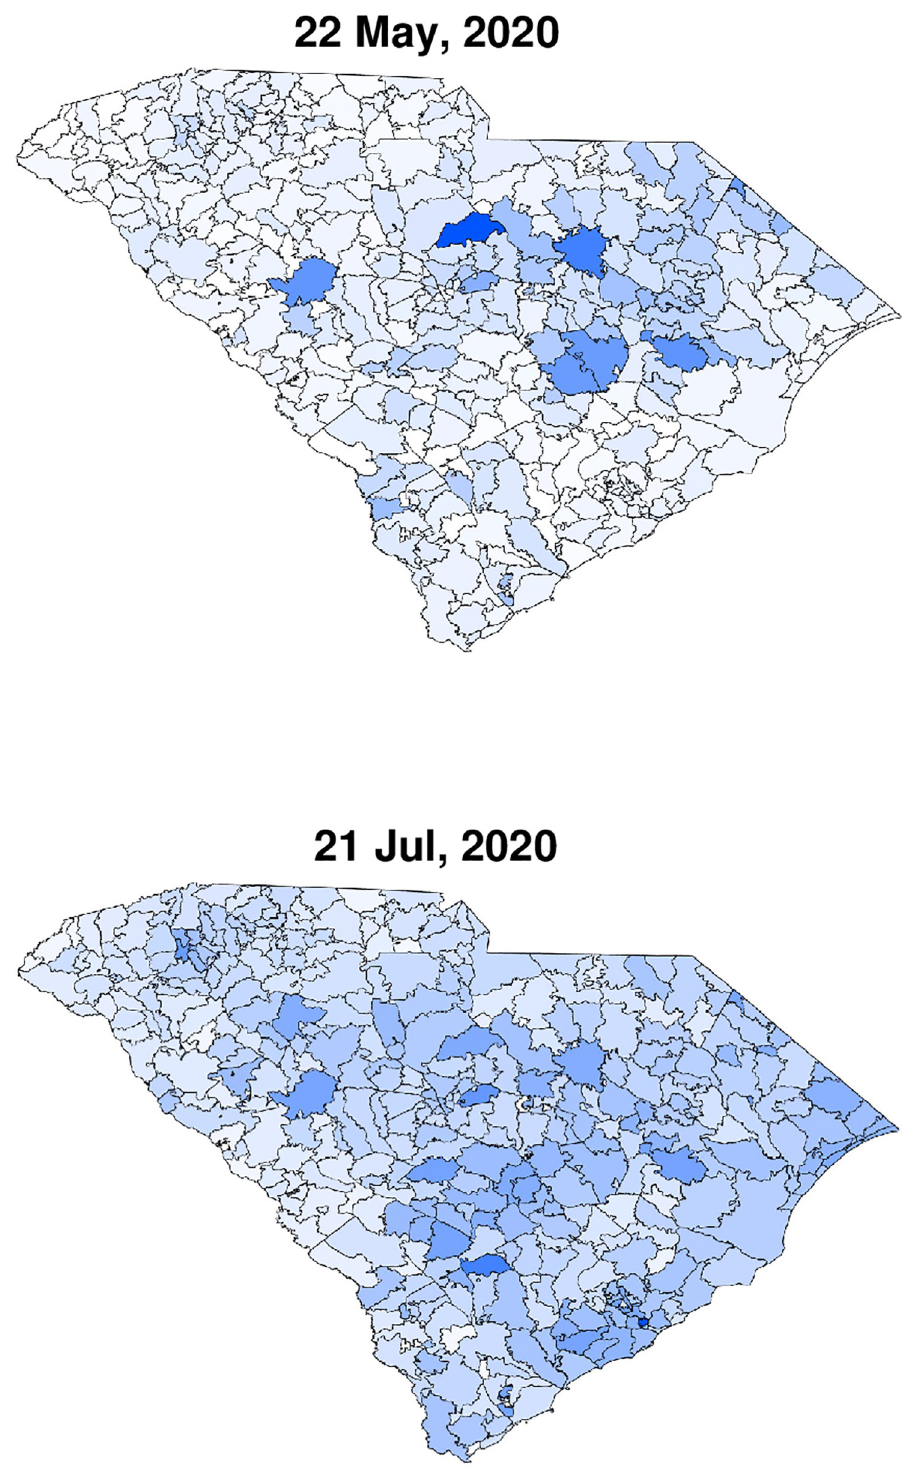
Fig 2. Infection maps taken from the South Carolina DHEC. The top figure corresponds to the initial time of the simulation ( t = 0), while the bottom, two months later, is the last time. The top figure serves as the initial condition for the